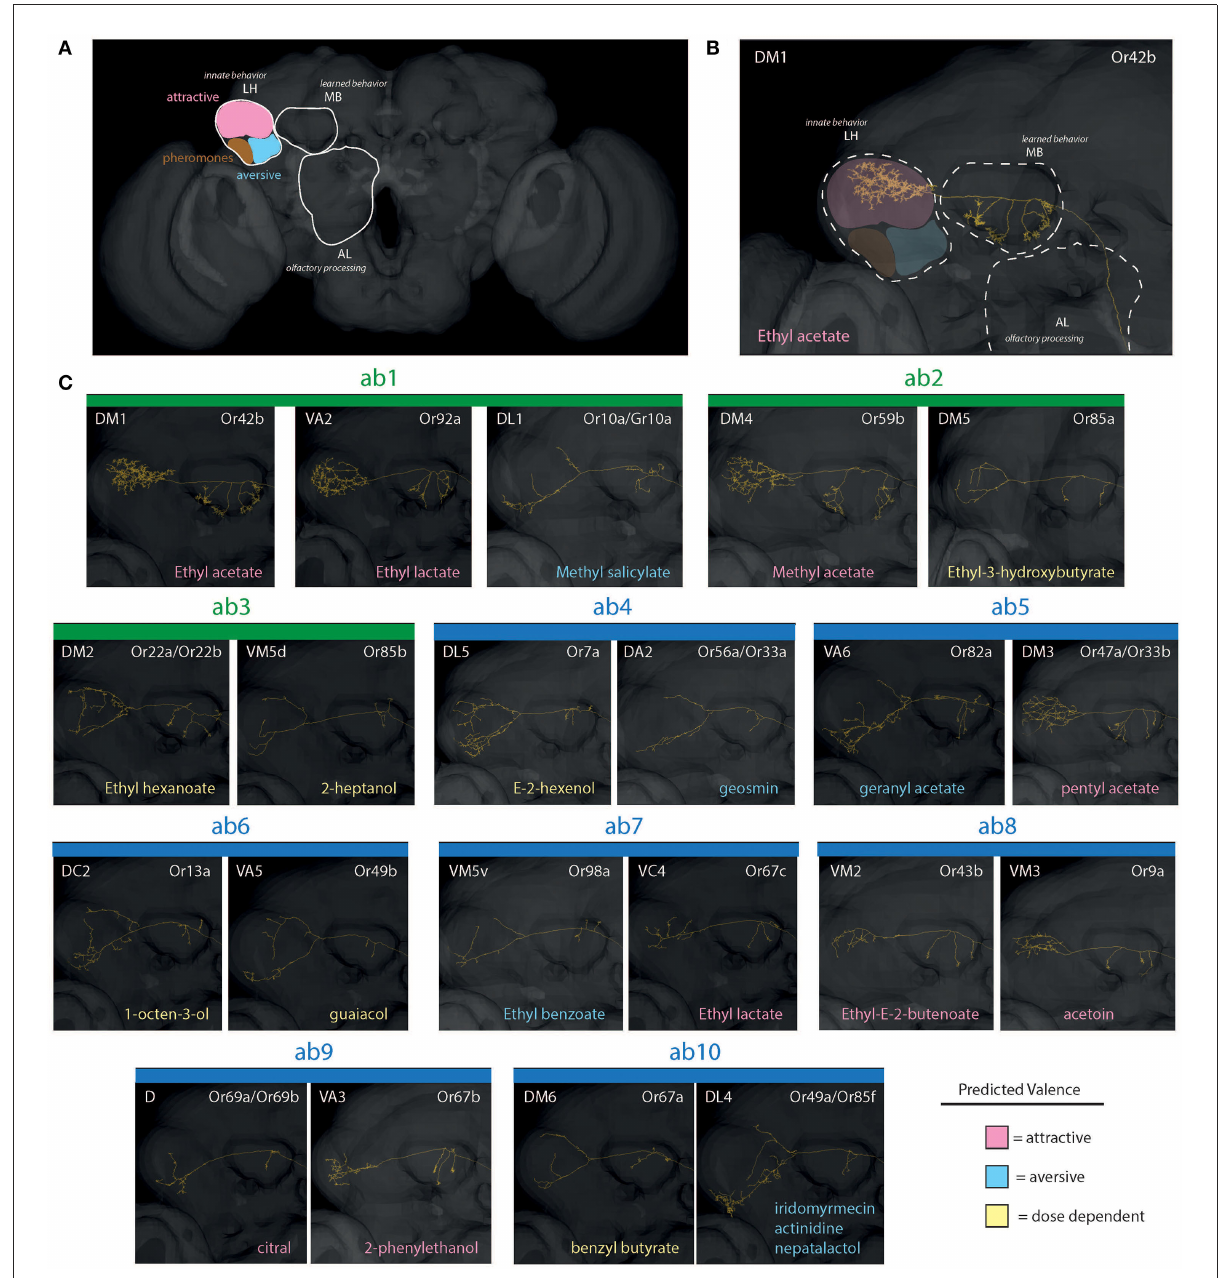
FIGURE4 Reconstructions of PNs for olfaction (basiconic sensilla). (A) An overview of neuropils, including AL, MB, and LH. Here, the LH is further subdivided into distinct innate behavioral zones related to chemosensory stimuli. (B) A close up example of the single neuron pathway through AL, MB, and into LH (in this case, within an attractive zone of innate behavior). (C) Projection neurons (PNs) from antennal basiconics (ab1-ab10; green = large basiconic; blue = small basiconic). The ab1, for example, depicting 2 predicted attractive regions of LH (pink), and 1 predicted aversive arborization (blue). Most aversive odorants possess projection neurons that map toward the lower portion of the LH, thus appear as “Y” shaped. Also, note differences in arborizations within MB between attractive and aversive neuron subtypes, with attractive neurons have many arborizations and aversive having only a few (e.g., DA2 in ab4 vs. DM1 in ab1 sensillum). AL, antennal lobe; OL, optic lobe; MB, mushroom body; LH, lateral horn; PN, projection neurons.